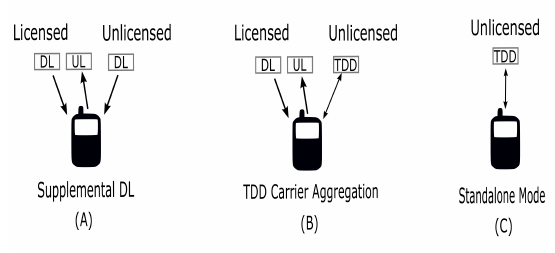
Figure 4. Different modes of operation for the LTE in the unlicensed